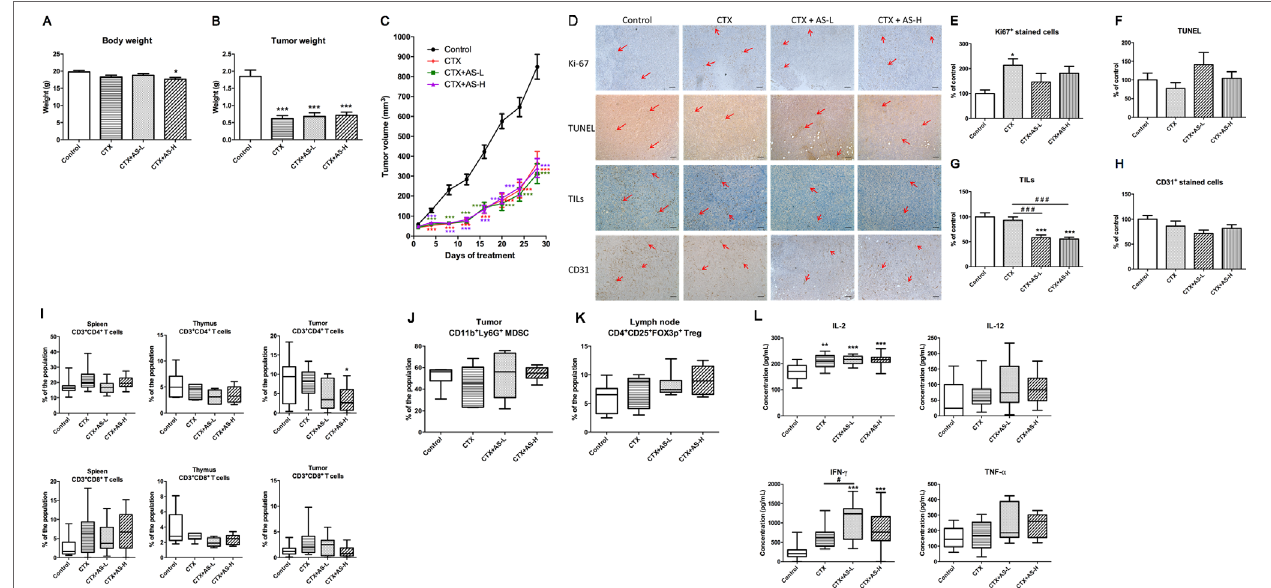
FIGURE 5 | Tumor growth of 4T1 tumor-bearing mice treated with cyclophosphamide (CTX). Mice with tumors were treated with cyclophosphamide (CTX) for 3 days, then followed by treatment with AS-L (0.75 g/kg) or AS-H (1.5 g/kg) daily for 4 weeks. (A) Body weights and (C) tumor volume of mice in each group were measured once every 3 days during treatments. Data were expressed as mean ± SEM, n = 13–15. (B) Tumor weights of mice after AS treatments were recorded at the end of treatment. (D) Representative images of immunohistochemical staining in the tumor sections (magnification = 100×, scale bar: 100 µ m). (E–H) Quantification of positive staining cells in tumor sections was conducted in a blinded manner. Data were expressed as mean + SEM, n = 13–15. Statistical differences were determined by one-way ANOVA, followed by post hoc Tukey’s multiple comparisons test. *p < 0.05, ***p < 0.001, as compared with control group. ### p < 0.001 as compared among different groups. (I–L) The immune responses of 4T1 tumor-bearing mice treated with CTX. Changes in the populations of (I) CD3+CD4+ (cytotoxic T-cells), CD3+CD8+ (Helper T-cells) in spleen, thymus, and tumor, (J) myeloid-derived suppressor cells in tumor, and (K) regulatory T-cells in lymph node were determined using flow cytometry. (L) The levels of cytokines (IL-2, IL-12, IFN- γ , and TNF- α ) of spleen lymphocytes (co-incubated with CD3). Data were expressed as mean + SEM, n = 13–15. Statistical differences were determined by one-way ANOVA, followed by post hoc Tukey’s multiple comparisons test. *p < 0.05, **p < 0.01, ***p < 0.001, as compared with control group. # p < 0.05 as compared among different